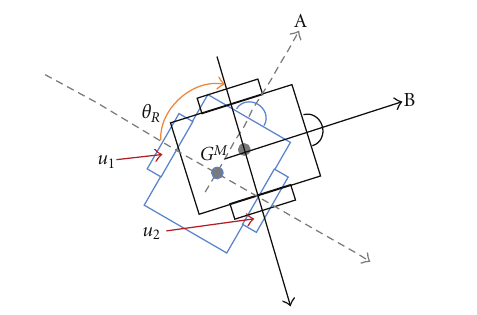
Figure 13: Angular displacement model alter applying a group u of pulses to the wheels. Point G M represents the point of interest in the robot, and plane R is defined from it. (a) Plane R before the pulse input, (b) plane R after the movement produced by the pulses.